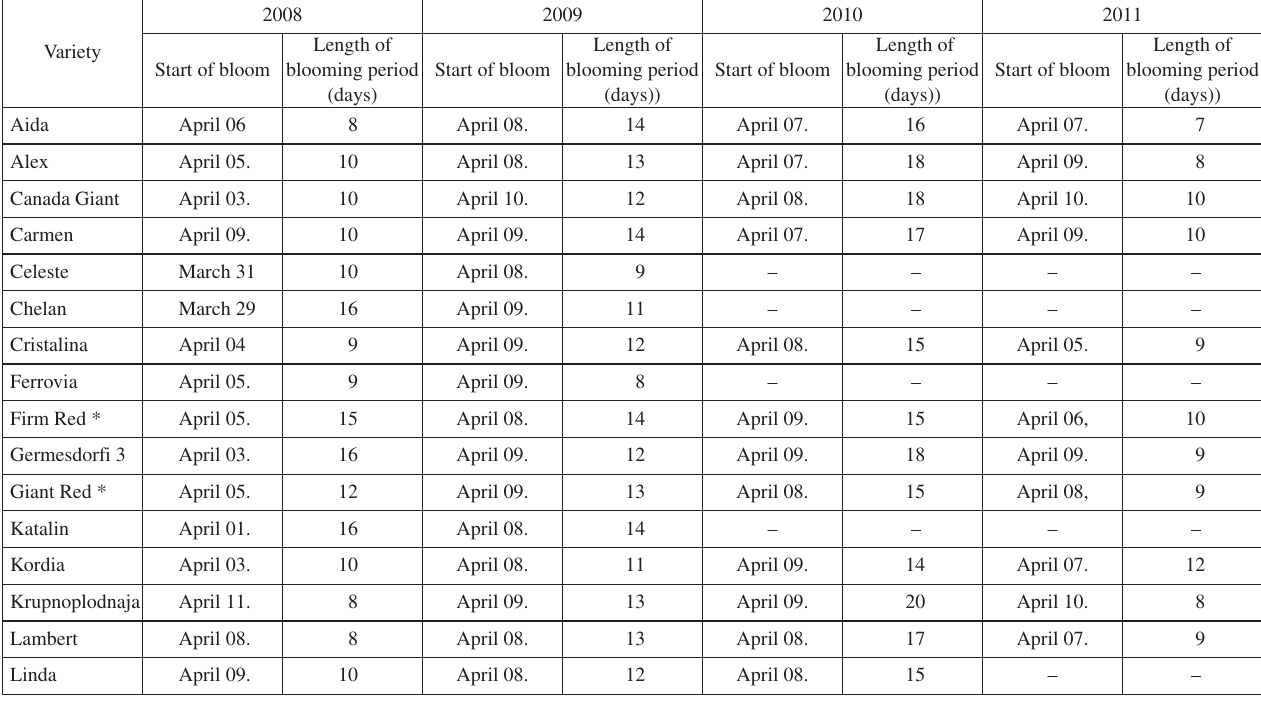
Table 1: Blooming dates of sweet cherry varieties at Nagykutas